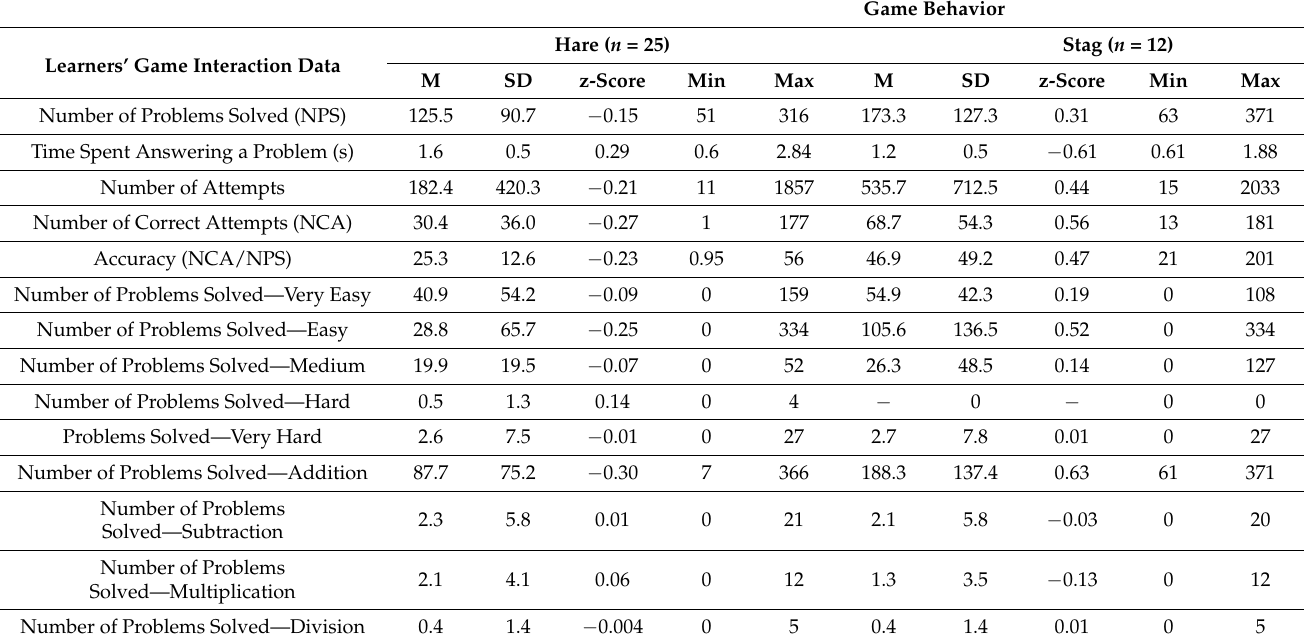
Table 5. Learners’ game interaction data (e.g., number of problems solved, time spent answering a problem, number of attempts, etc.) were standardized using z-scores.